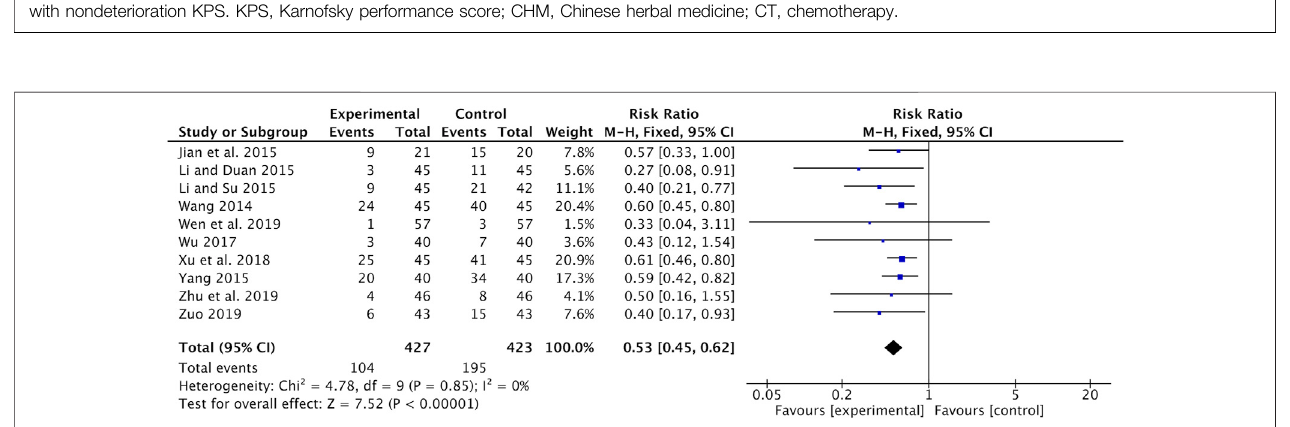
FIGURE5| ForestplotofnauseaandvomitingofAstragalus-containingCHMcombinedwithCTvs.CTalone.CHM,Chineseherbalmedicine;CT,chemotherapy.